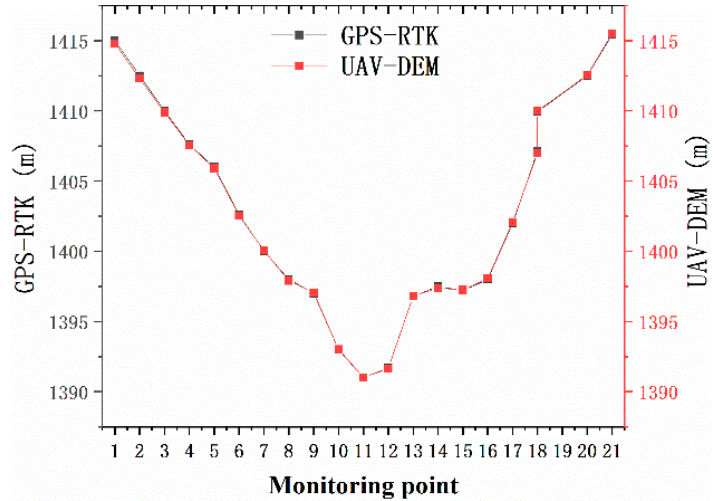
Figure 4. The elevation value obtained by the DEM and the elevation value obtained by the field measurement (along the mining direction). Source: Built on the basis of the author’s field survey and calculations.